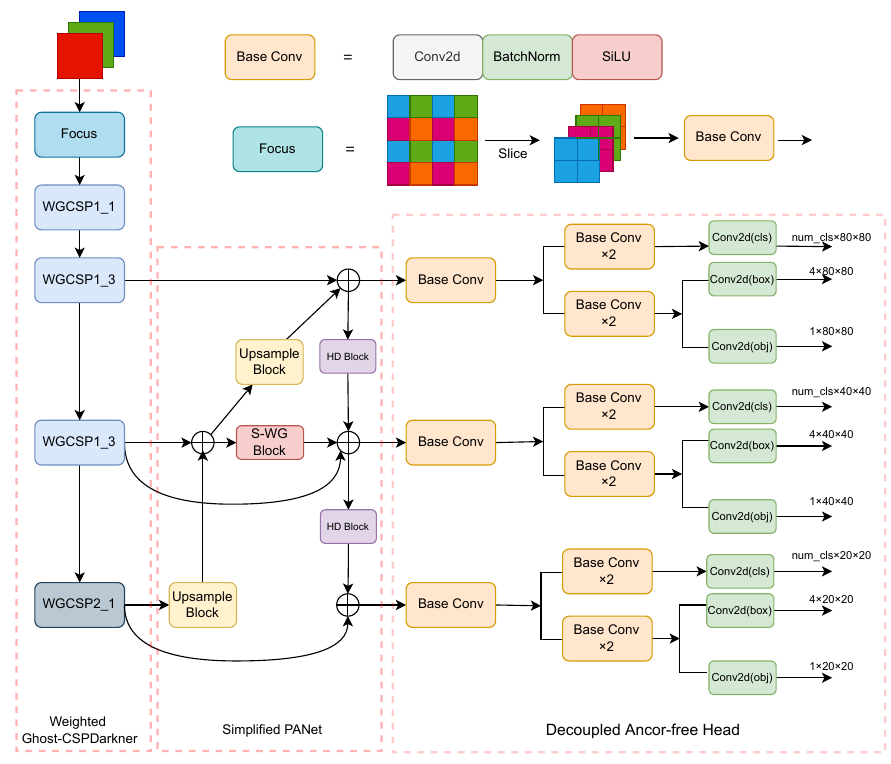
Figure 2. The block diagram of the LUO-YOLOX model.